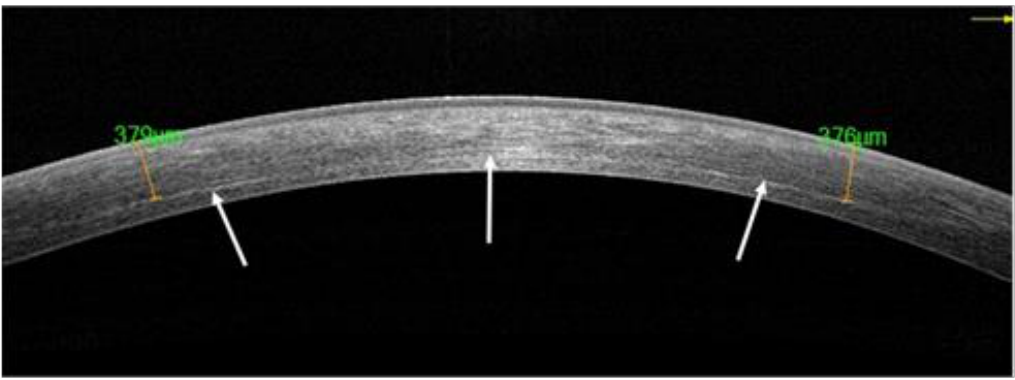
Figure 6. First postoperative month control shows the demarcation line depth (DLD, white arrows) as measured by spectral domain anterior-segment (AS) corneal OCT (optical coherence tomography).